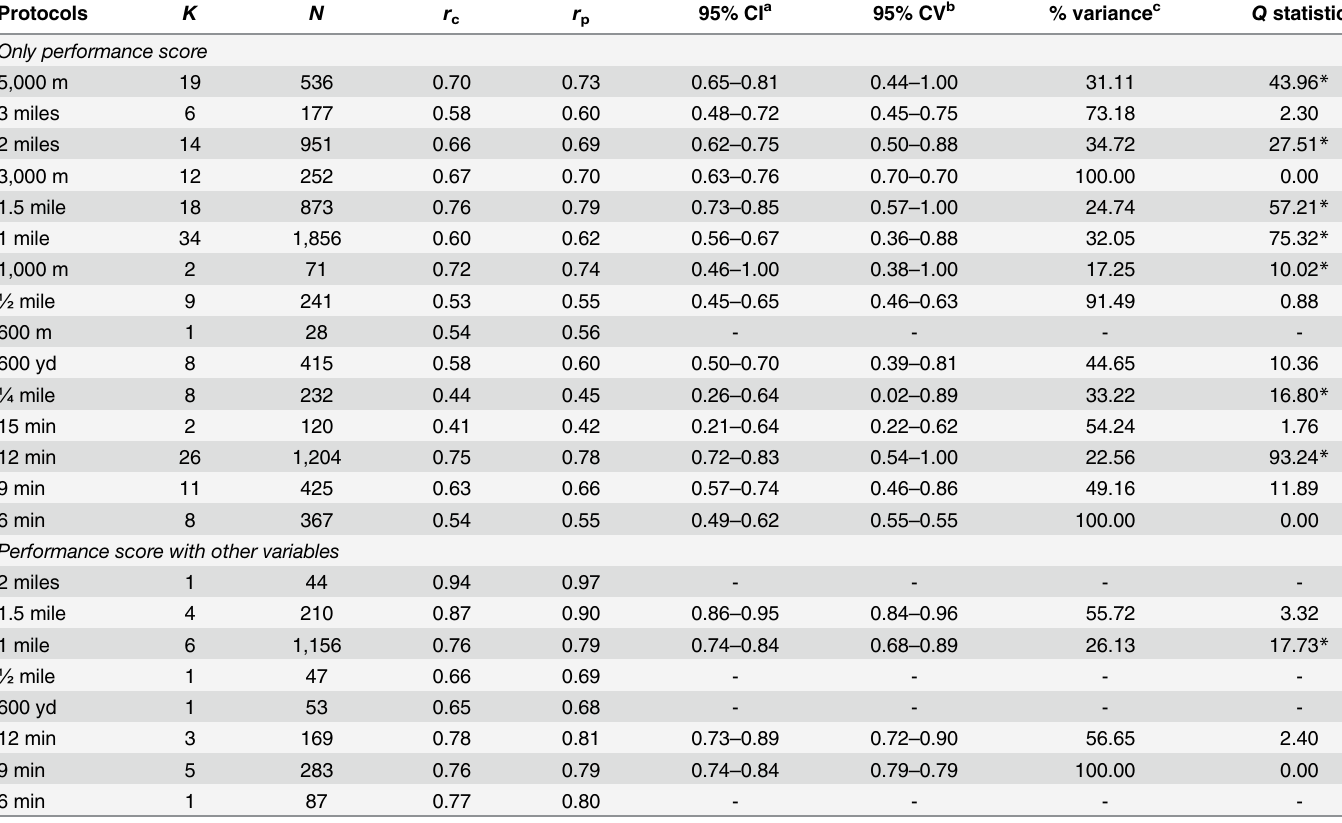
Table 1. Results of meta-analyses for overall criterion-related validity correlation coefficients across the distance- and time-based walk/run field